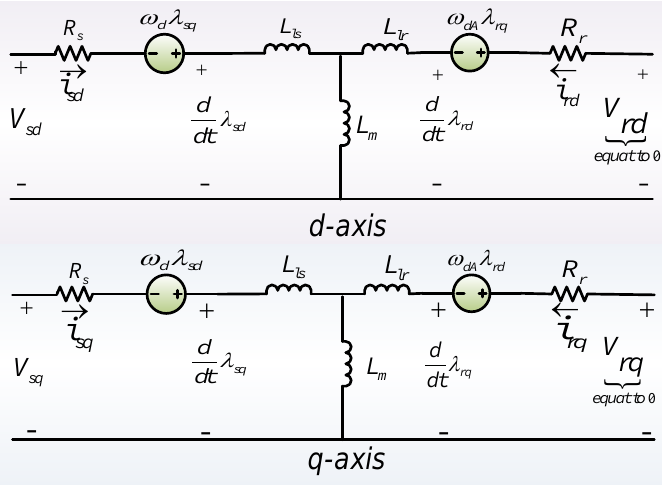
Figure 1. The dq equivalent circuits of the induction motor (IM).